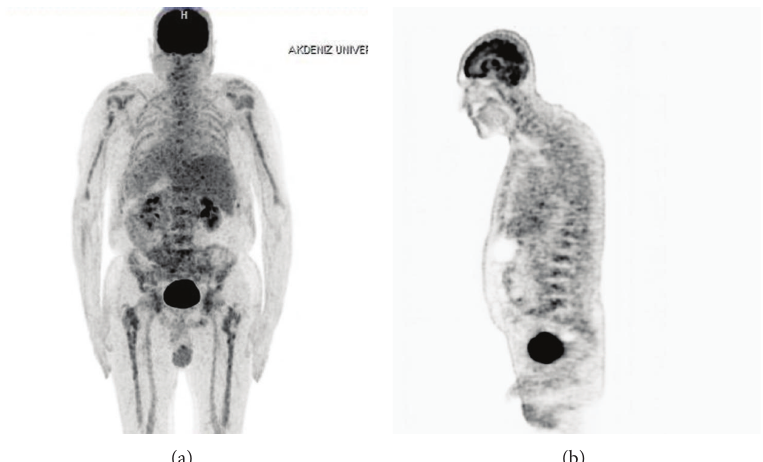
Figure 3: This figure shows no 18F-fluoro-2-deoxi-D-glucose (FDG) involvement except bone metastases in PET ((a) coronal section and (b) sagittal section).